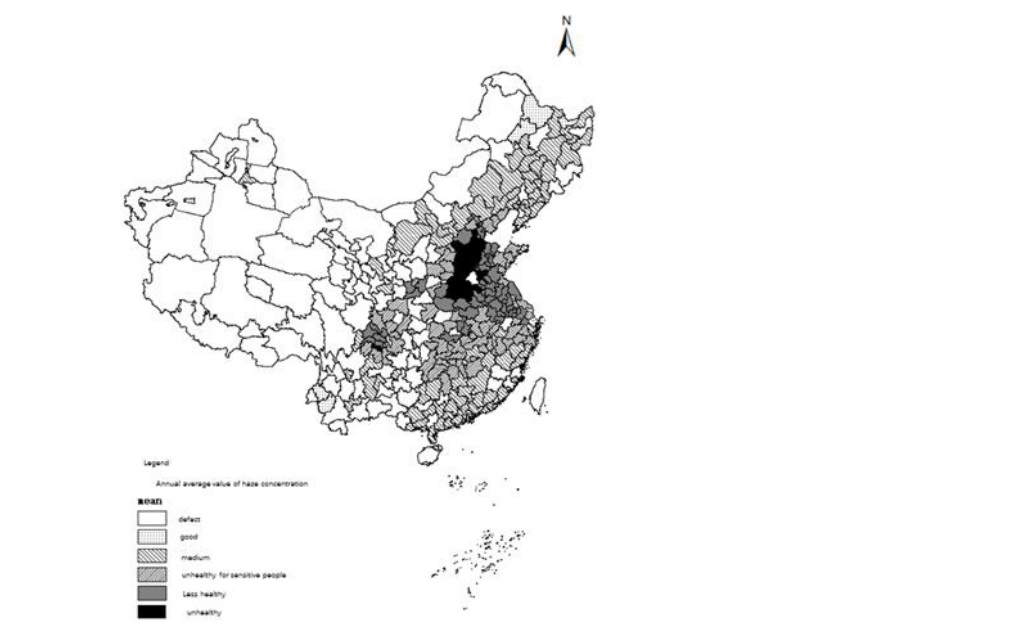
Figure 3. Annual Average Concentration of Haze from 2010 to 2012 in Chinese Prefecture-Level Cities. Source: Map of Global Annual Average Surface PM 2.5 Concentrations from SEDAC. https://sedac.ciesin.columbia.edu/ (accessed on 20 December 2021).